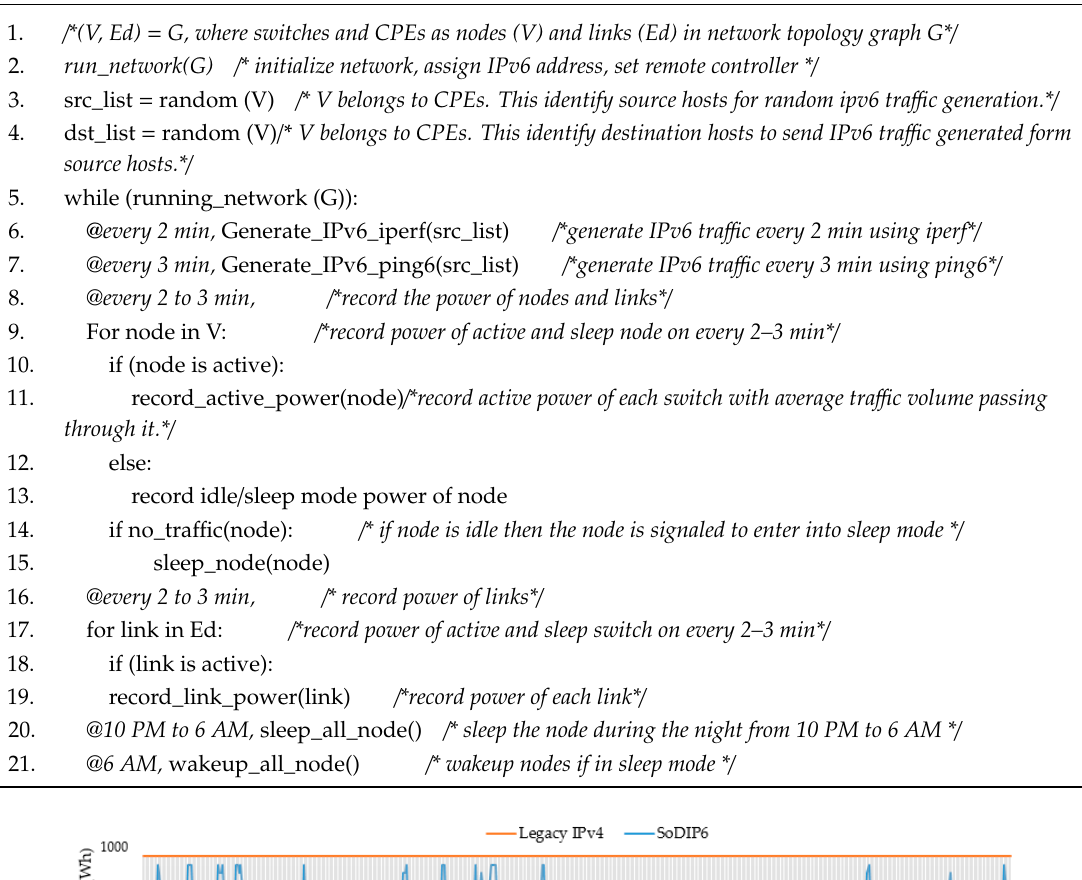
Algorithm 1 Pattern of Energy Consumption Recording of the SoDIP6 Network 1.